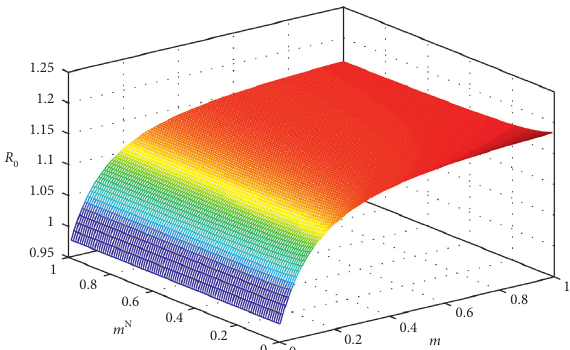
Figure 3: The effects of the diffusion rates on the net reproduction � 0 . 96, R � 0 . 98, K � 2 . 8, K � 2 . 45, where R number R 0 01 02 1 2 d N � 0 . 18, d N � 0 . 15, and m N , m J � m A � m vary from 0.01 to 1; 1 2 all other parameters are given in equation